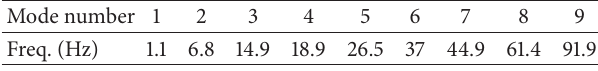
Table 3: The first 10 natural frequencies of the rectangular